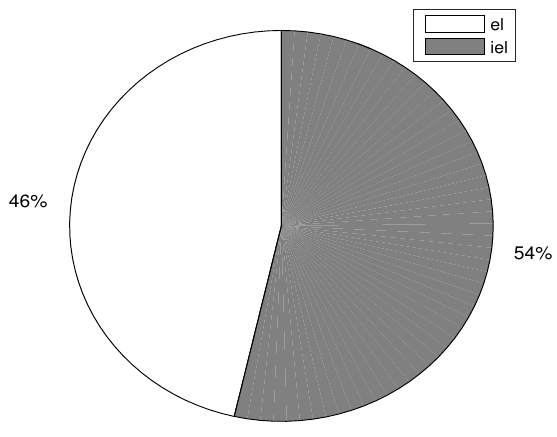
Figure 22. User comfort in case of el and iel